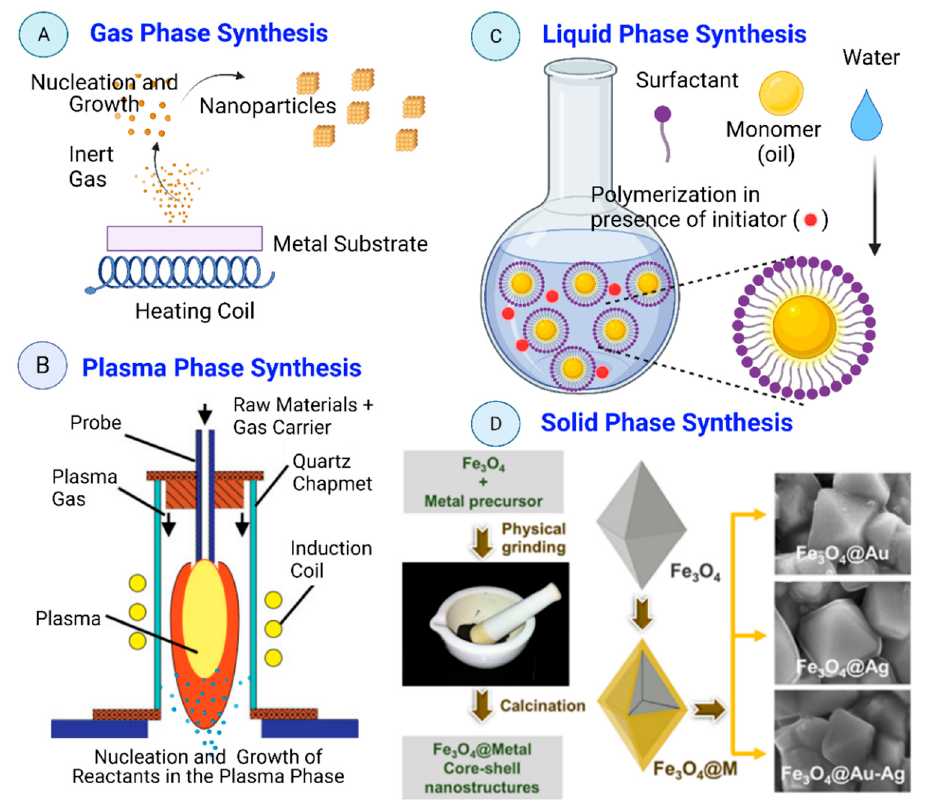
Figure 13. Nanomaterial production using different synthesis techniques: ( A ) Inert gas synthesis of metal nanoparticles from thermal evaporation of a metal substrate in the presence of the inert gas and then nanoparticles condensation (nucleation and growth) on a cold substrate; ( B ) Thermal plasma synthesis of NPs using different plasma-phase chemical reactions as bottom-up approaches; ( C ) Emulsion polymerization of monomers (oil phase) in water (liquid phase) in the presence of an imitator and a surfactant; ( D ) solid-phase synthesis of core-shell noble metal @Fe 3 O 4 nanostructures [190]; © Nature, 2019.